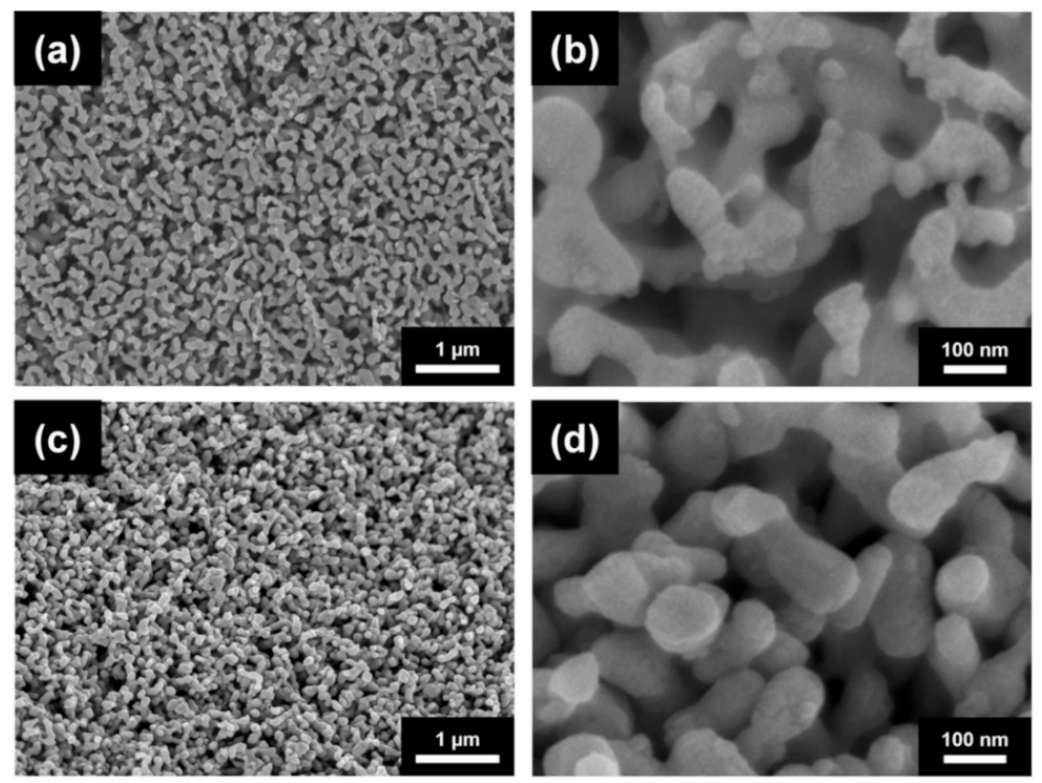
Figure 9. SEM images of Cu nanofoams oxidized at ( a , b ) 110 ◦ C for 30 min and ( c , d ) at 140 ◦ C for 30